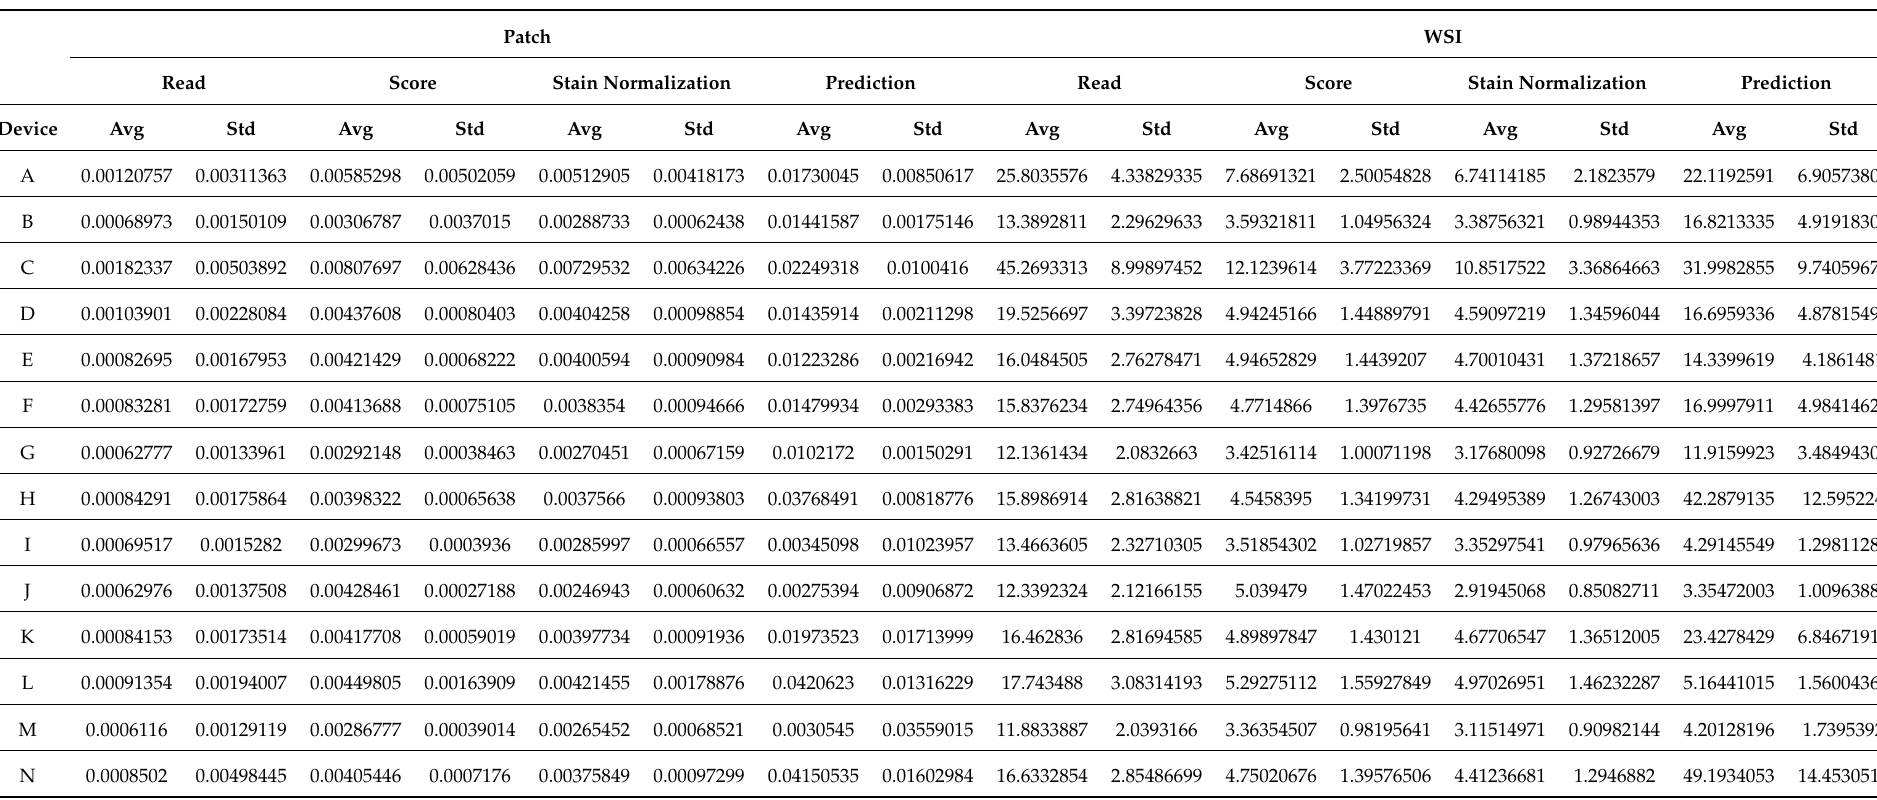
Table A2. PROMETEO evaluation results. The average (Avg) and standard deviation (Std) of the execution times (in seconds) are shown for each of the four processes presented in Section 2.3 (Figure 1), both at patch level and at slide (WSI)